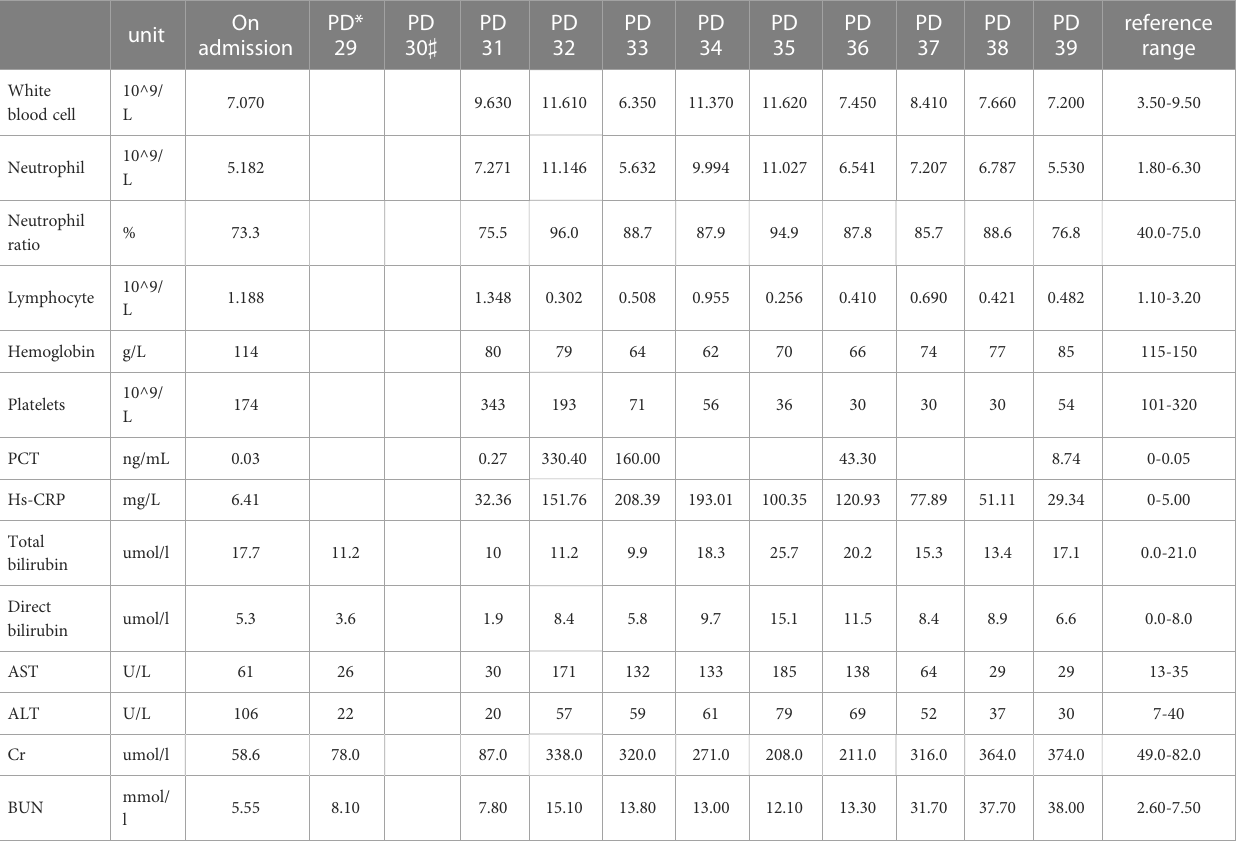
TABLE 1 The variations trend of laboratory data.